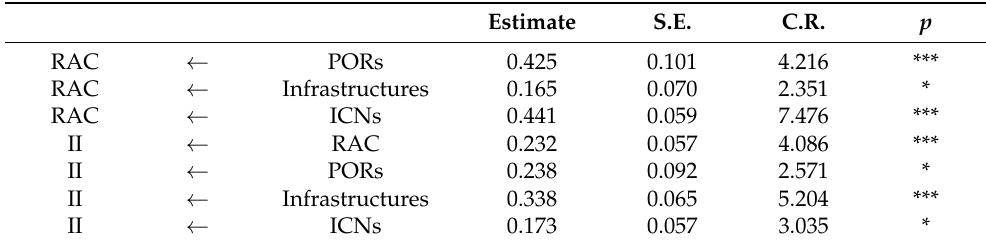
Table 5. Influence of IS on II of health and wellness tourism industry.